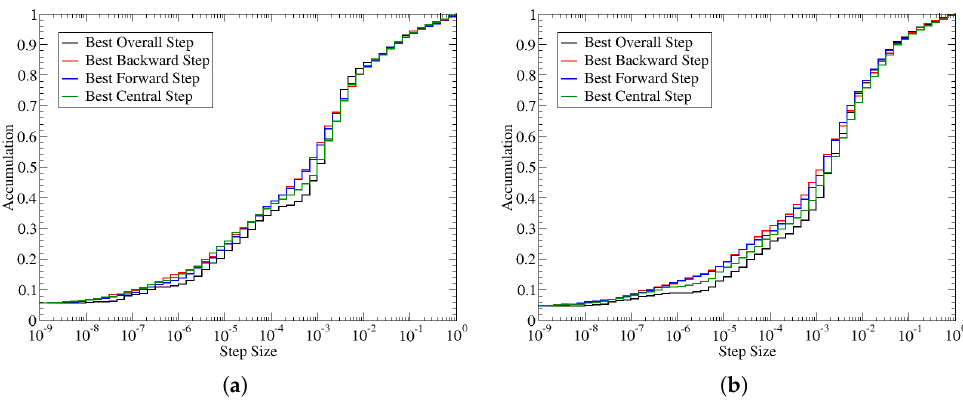
Figure 4. The best step size for each term in the Jacobian. ( a ) Straight blade. ( b ) Swept blade. The coefficient of determination statistics also provides a measure of quality for the gradients. The quality measure used here was 1 − mean ( R 2 ) + stdev ( R 2 ) . Lower values of this measure reflect better quality gradients, as shown in Figure 3. For each